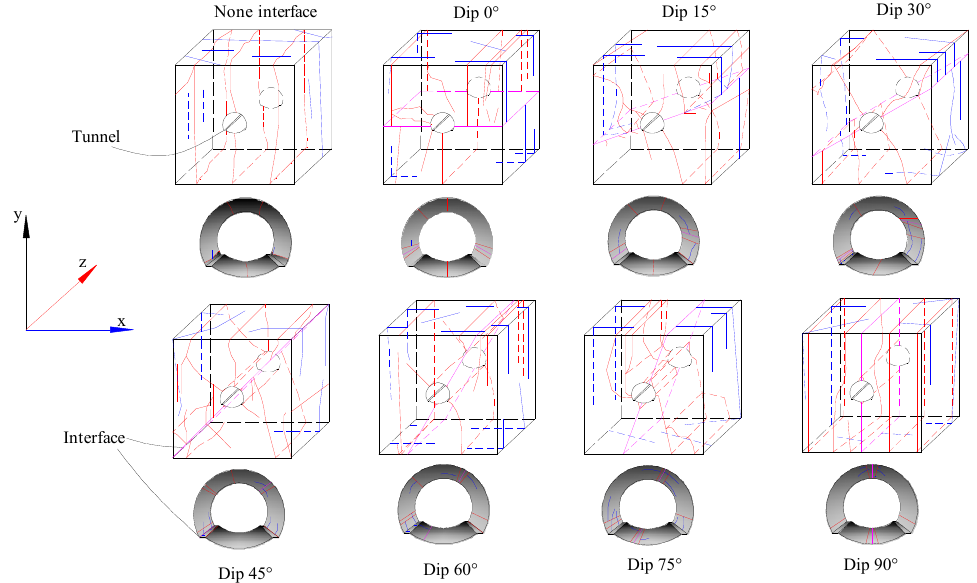
Figure 7. Crack development. Under the action of pressure, the paint on the surface is detached from the sample, resulting in uneven surface.